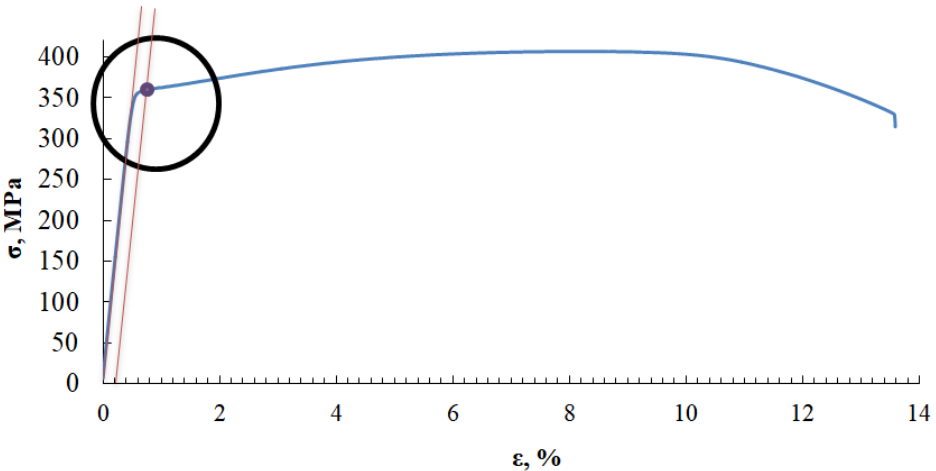
Figure 2. Diagram σ - ε for the analyzed Sample No. 3 made of AW 7020 alloy, with a marked fragment subject to further analysis, as well as with a point which corresponds to the arbitrary yield point R 0.2 .